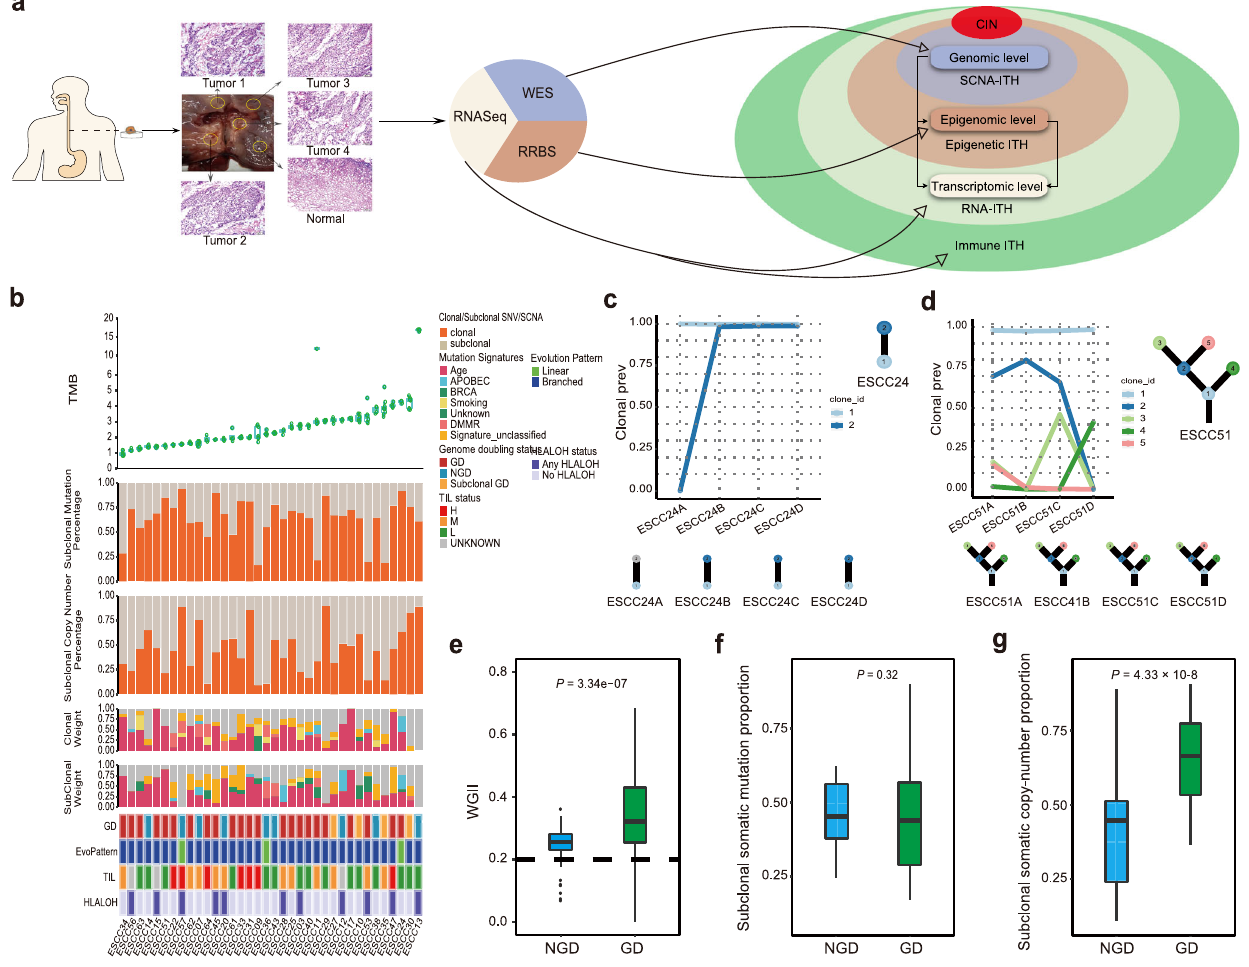
Fig. 1 | Fuels of Genomic ITH in ESCC. a Overview of the experimental strategy. Each ESCC multi-sites samples of patients was performed using WES, RNASeq and RRBS to explore the intrinsic multiple omics ITH, the extrinsic TILs ITH and the fuelsofeachomicITH. b Thetoppanelshowsthetumormutationalburden(TMB) for each tumor region ( n =186). The minimum and maximum are indicated by the extremepointsoftheboxplot;themedianisindicatedbythethickhorizontalline; and the fi rst and third quartiles are indicated by box edges. The second and third- panel shows the proportion of somatic mutations and copy-number alterations that are identi fi ed as clonal (deep blue bars) or subclonal (orange bars) in each patient. The fourth and fi fth-panel show the mutation signatures weight identi fi ed intheESCCcohortbyusingclonalandsubclonalsomaticmutationsseparately.The bottom panel shows the summary of the genome doubling (GD), evolution pat- terns, TIL group, and HLALOH status for each patient ( n =36). c , d The top panel